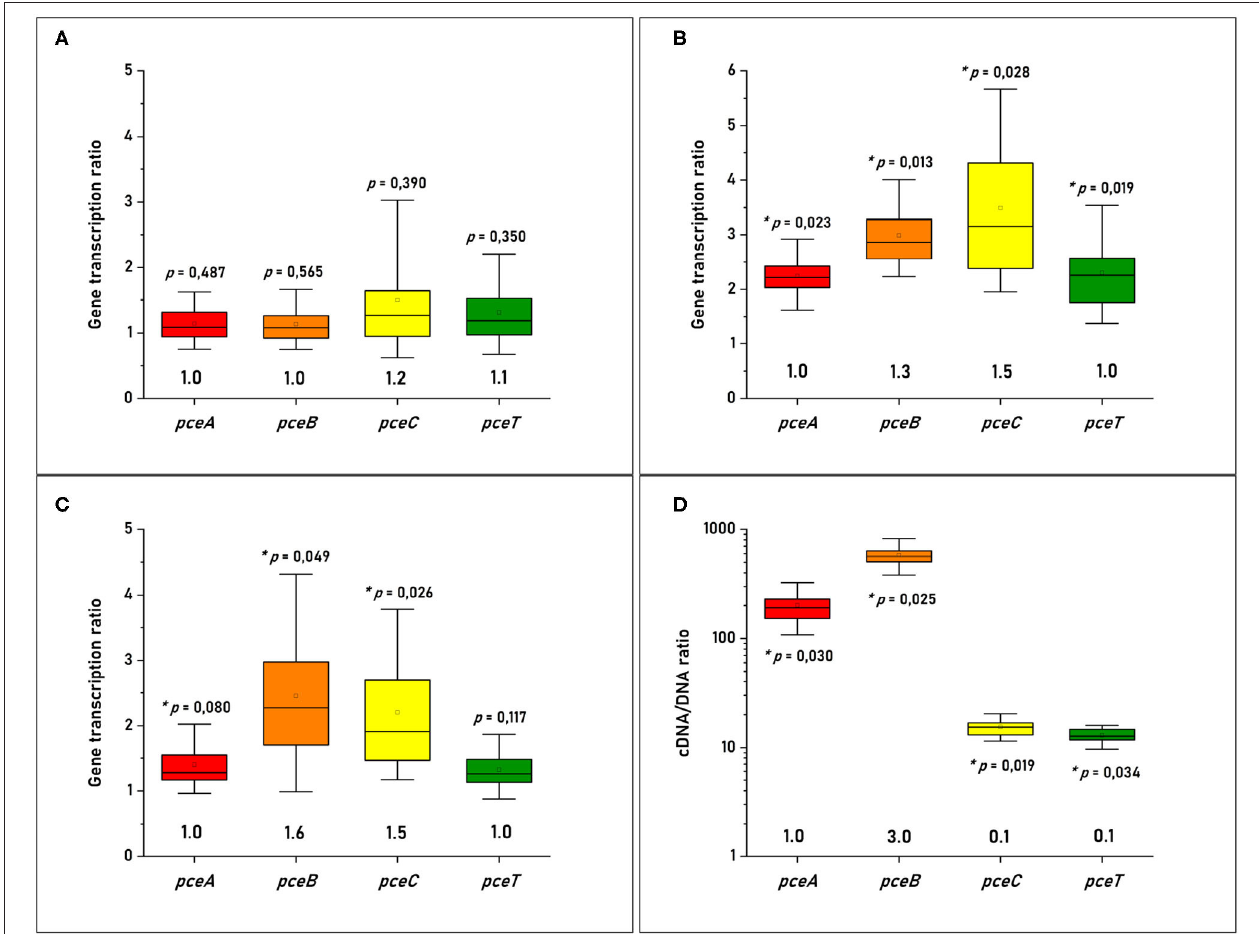
FIGURE 2 | Quantitative analysis of the individual pce transcripts in (A) D. hafniense strain TCE1 cultivated on pyruvate and spiked with PCE; (B) D. hafniense strain TCE1 routinely cultivated with H 2 and PCE; (C) D. hafniense strain TCE1 routinely cultivated with pyruvate and PCE; and (D) D. restrictus routinely cultivated with H 2 and PCE. Please note that the transcriptional data of D. hafniense strain TCE1 were compared to transcripts obtained from cells routinely cultivated with pyruvate, while the gene transcription ratio of D. restrictus was calculated using DNA as